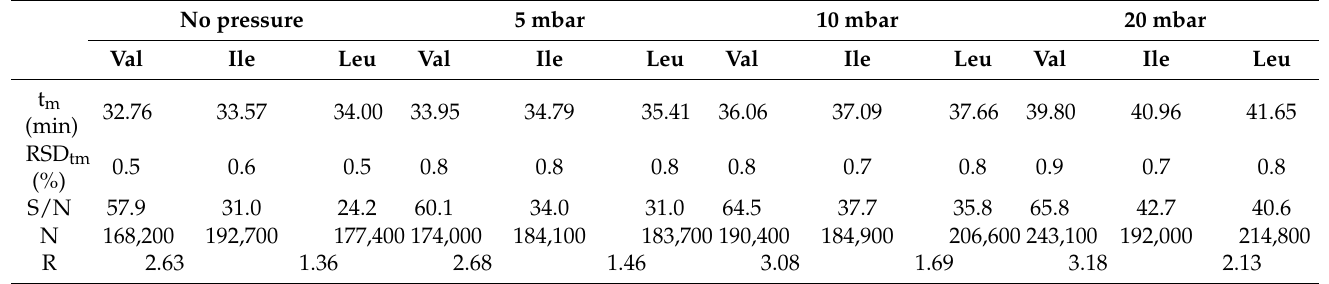
Table 2. Effect of the negative pressure application on the separation of